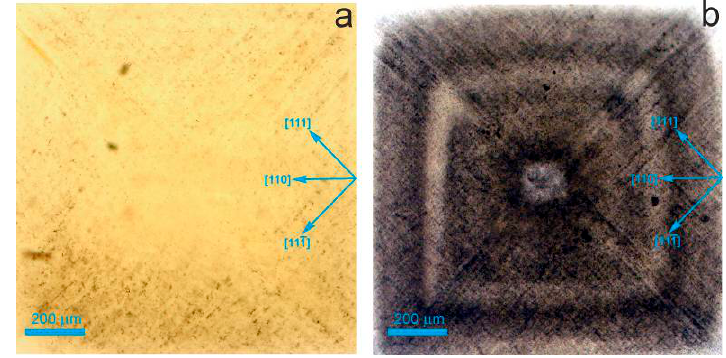
Figure 4. Core regions of diamonds ( a —M-30, b —MP-87) with abundant microinclusions.